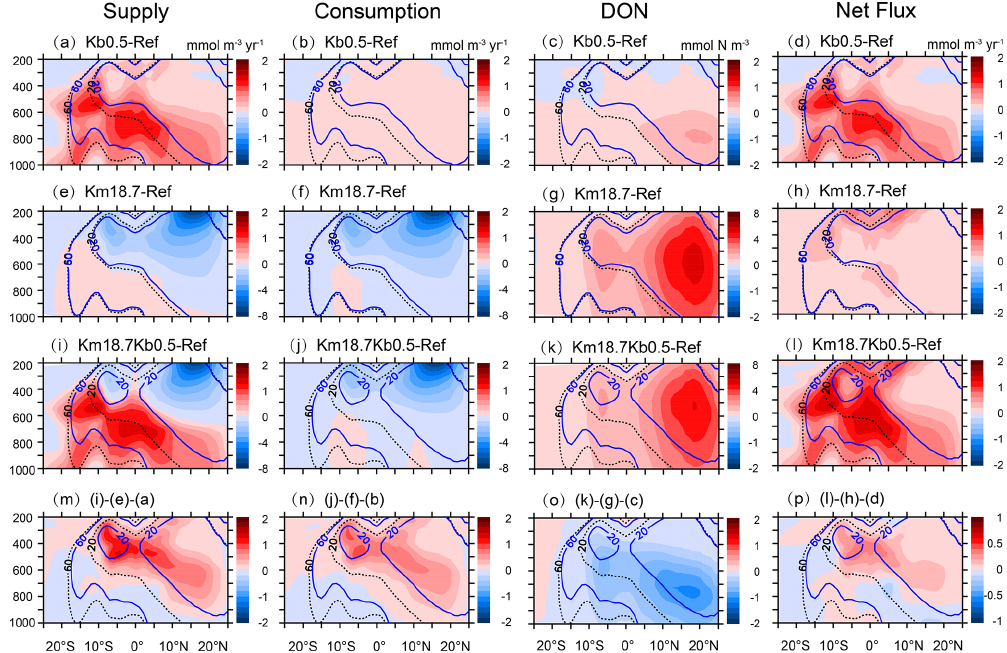
Figure 10. Changes in physical supply, biological consumption, DON concentration, and net flux over 120–90 ◦ W under an enhanced vertical mixing ( a, b, c, d ), a reduced O : C utilization ratio ( e, f, g, h ), combination effects ( i, j, k, l ), and the residuals or interactions ( m, n, o, p ). Black and blue lines denote contours of DO concentrations of 20 and 60mmolm − 3 from the reference run (dashed lines) and other simulations (solid